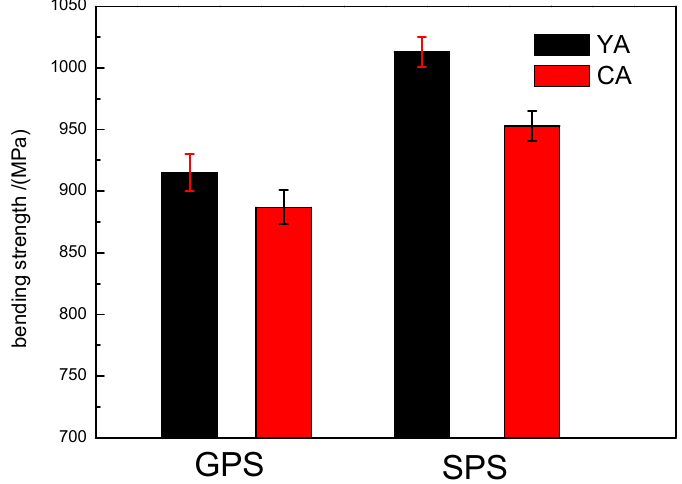
Figure 4. Bending strength (MPa) of GPS and SPS sintered silicon nitride samples.